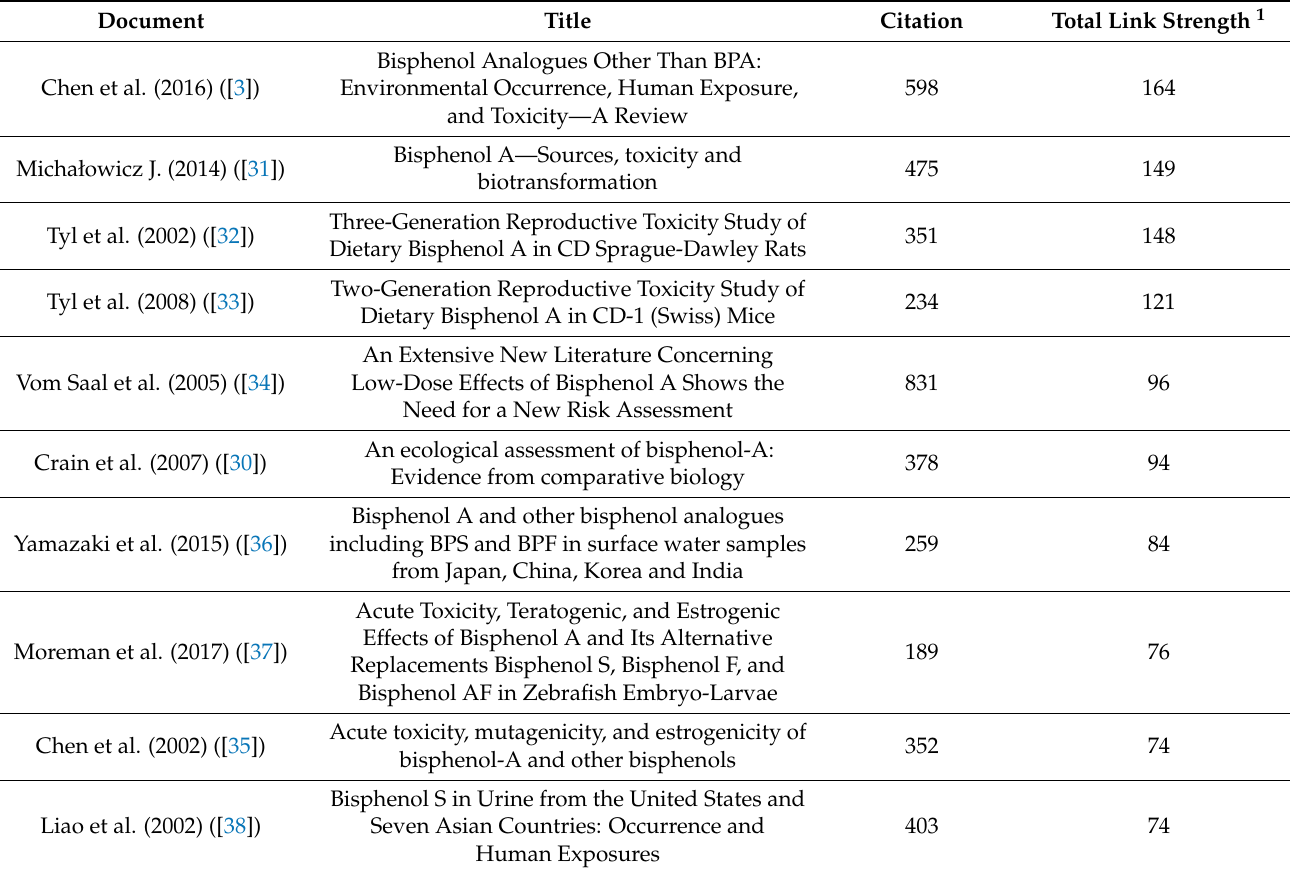
Table 4. Summary of titles and citations of top 10